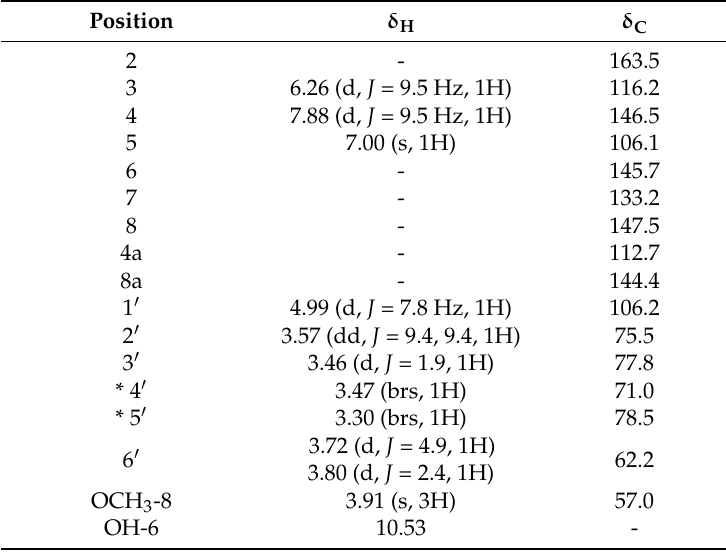
Table 1. The 1 H (600 MHz, δ in ppm, J in Hz) and 13 C NMR (125MHz, δ in ppm) spectral data for compound 15 in deuterated methanol (CD 3